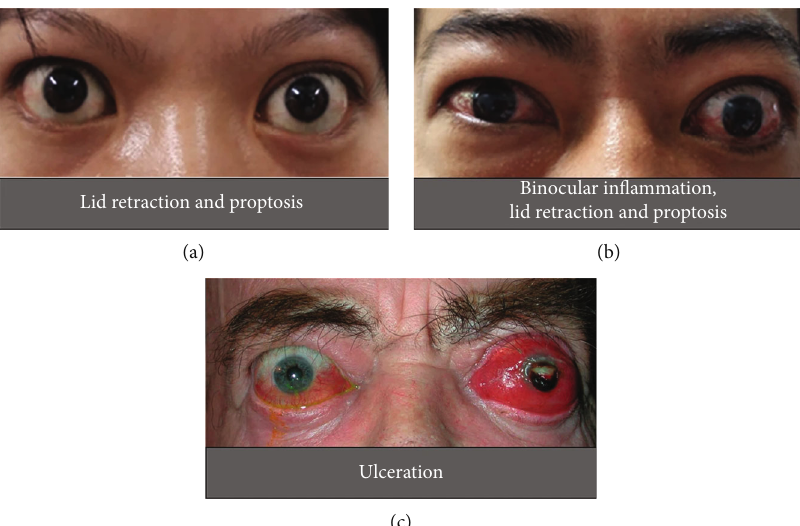
Figure 1: (a) Lid retraction and proptosis. (b) Binocular in fl ammation. (c) Ulceration. Reproduced with permission from Douglas